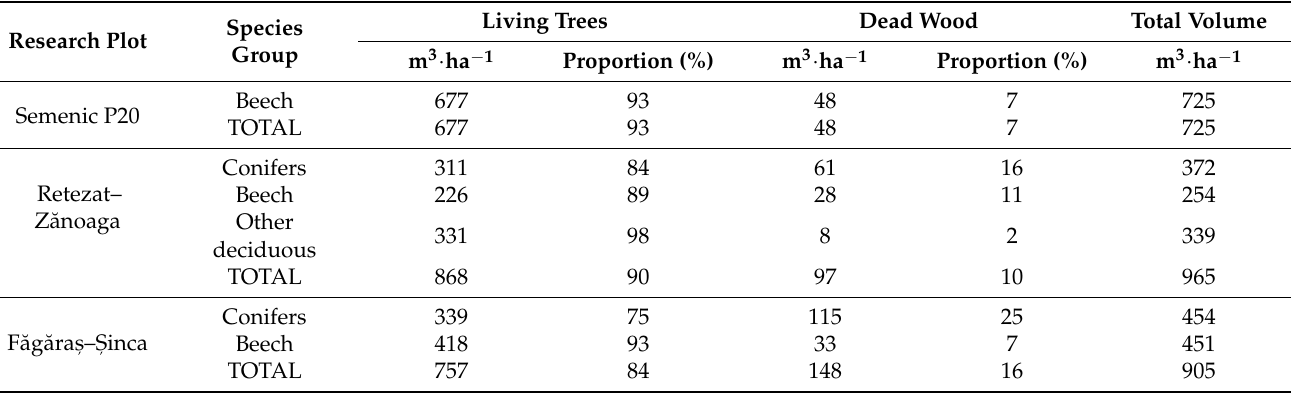
Table 4. Volume of dead wood and living trees related to the group of species.